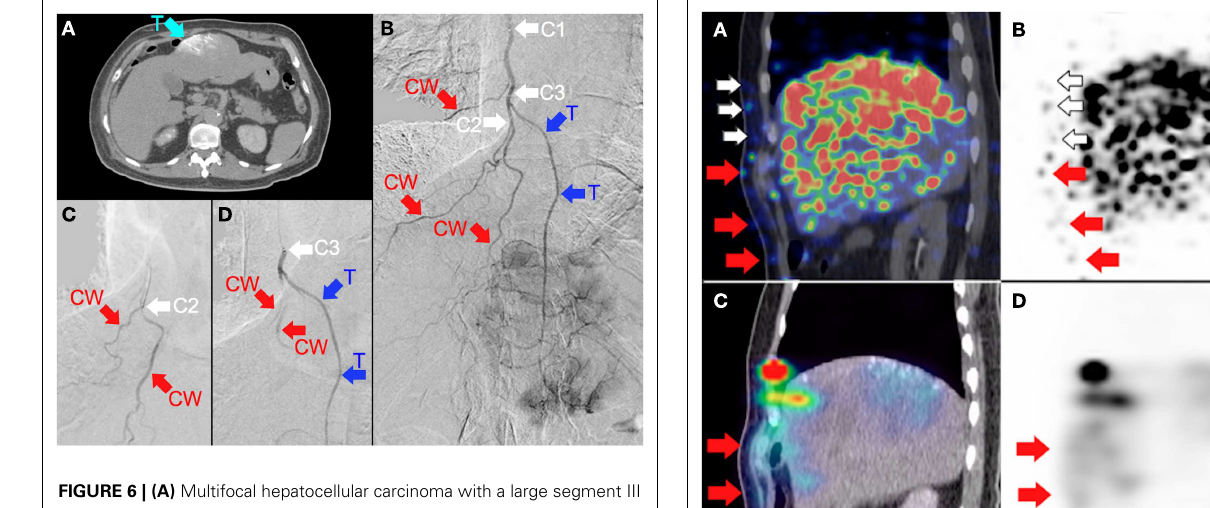
FIGURE 6 | (A) Multifocal hepatocellular carcinoma with a large segment III tumor. Catheter-directed CT hepatic angiogram of the right internal mammary artery (RIMA) demonstrates blood supply to one-third of the large segment III tumor (“T”). (B) Digital subtraction angiogram (DSA) of the RIMA demonstrates the target arterial tree, with three major branches supplying the right lower anterior chest wall (“CW”) and a terminal branch supplying tumor (“T”).The tumor blush is seen distally.The catheter tip was positioned at the proximal RIMA (“C1”) for 99m Tc MAA injection. (C) To